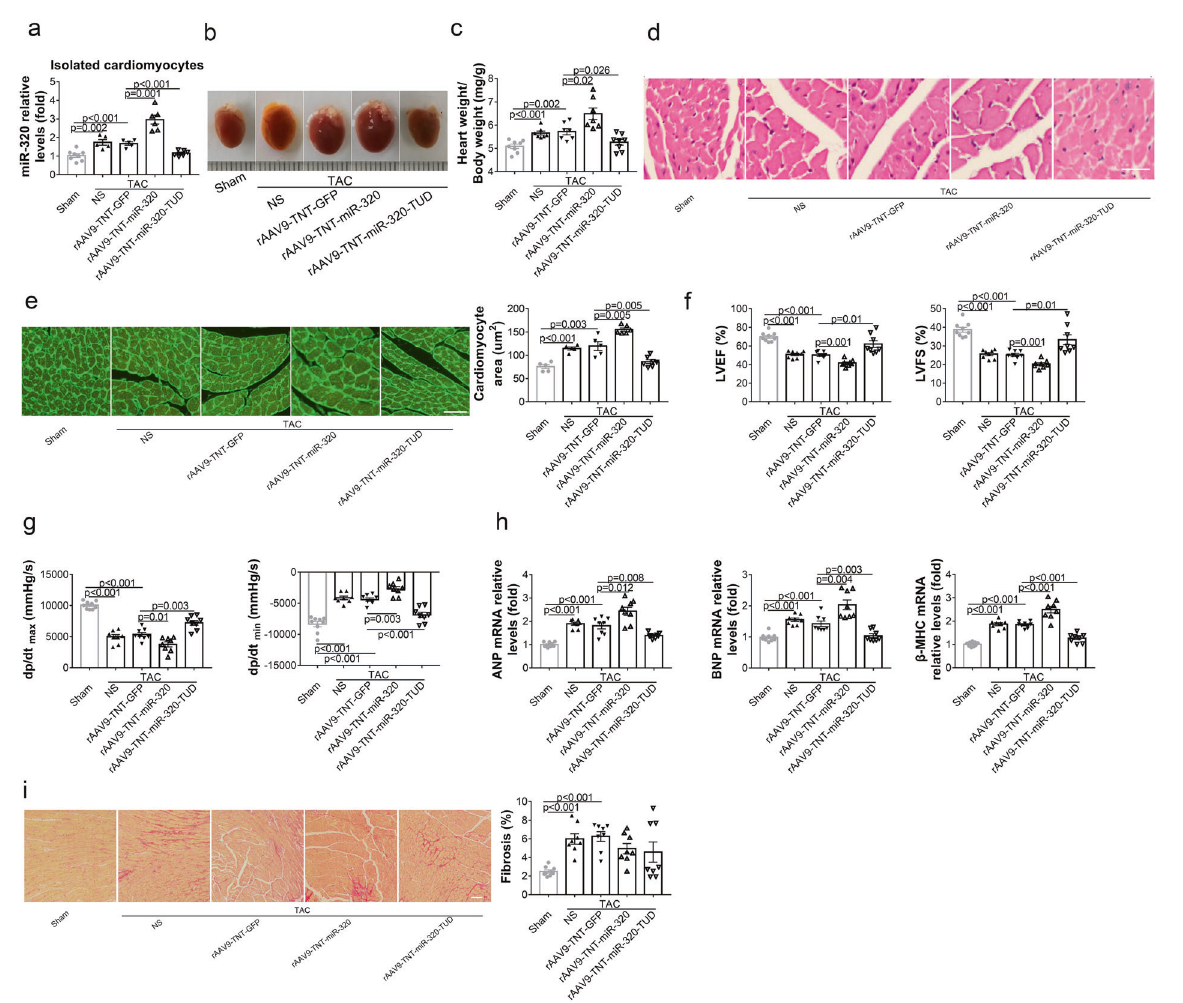
f Echocardiography analysis of LVEF%, LVFS%. g Hemodynamic parameters (dp/dt max and dp/dt min ) were measured by the Millar cardiac catheter system. h Relative mRNA expressions of cardiac hypertrophy markers in heart tissues from treated mice. i Representative images of Sirius Red staining of heart sections from mice with different treatments (left), and the quanti fi cation analysis of cardiac fi brosis (right). Scale bars, 50 µm. H&E hematoxylin and eosin, WGA wheat germ agglutinin. Sham ( n = 9), TAC + NS ( n = 8), TAC + rAAV9-TNT-GFP ( n = 8), TAC